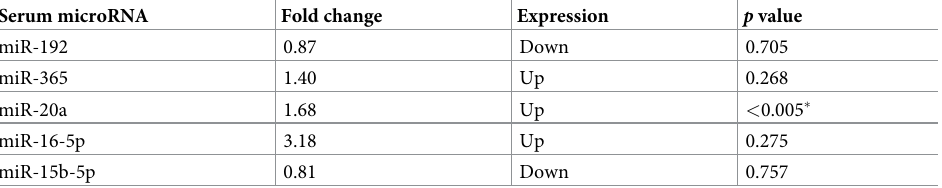
Table 6. Comparison between control and PKD group on miRNA expression ratios from feline